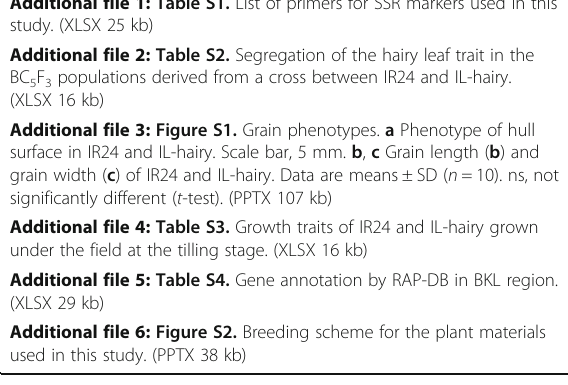
Additional file 6: Figure S2. Breeding scheme for the plant materials used in this study. (PPTX 38